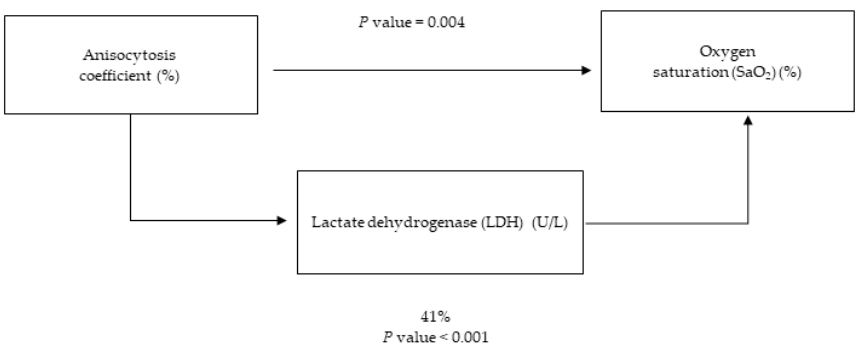
Figure 2. LDH (oxidative marker) level mediation on oxygen saturation (disease severity marker) using anisocytosis coefficient (inflammatory marker) in COVID ‐ 19 infected patients.